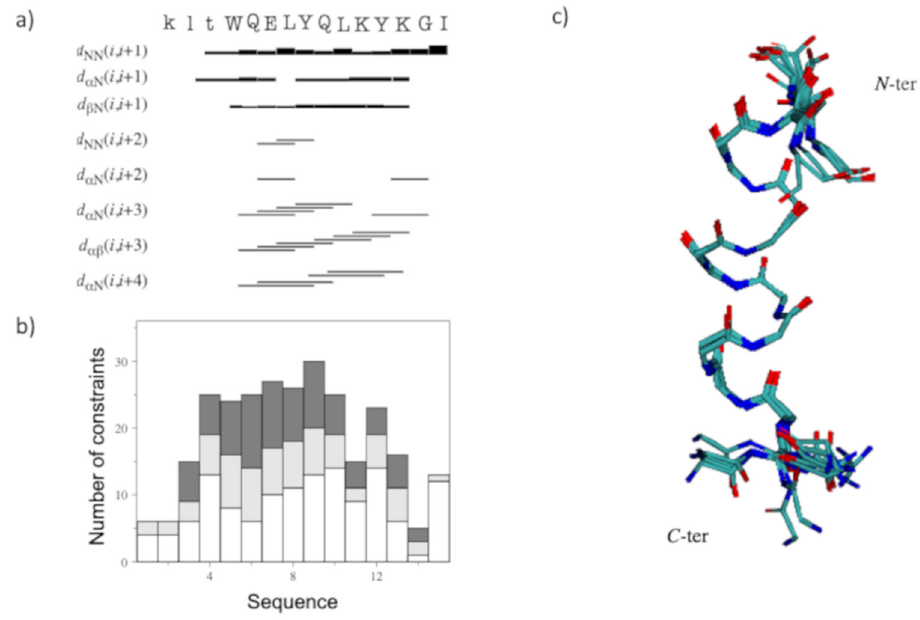
Figure 5. ( a ) D-QK NOEs diagram in H 2 O/TFE 70/30 v/v . The amino acids sequence is reported on top. Principal sequential and medium-range NOEs are shown; the thickness of each block is proportional to the corresponding NOE intensity. ( b ) Number of constraints per residue. White, light gray and dark gray bars indicate intra-residue, sequential, and medium-range connectivities, respectively. ( c ) Superposition of the minimized 20 best structures represented as ribbons (RMSD (N, Ca, C’(5–12) = 0.13 ± 0.05 Å). N-ter and C-ter refer to the amino and carboxyl termini, respectively.